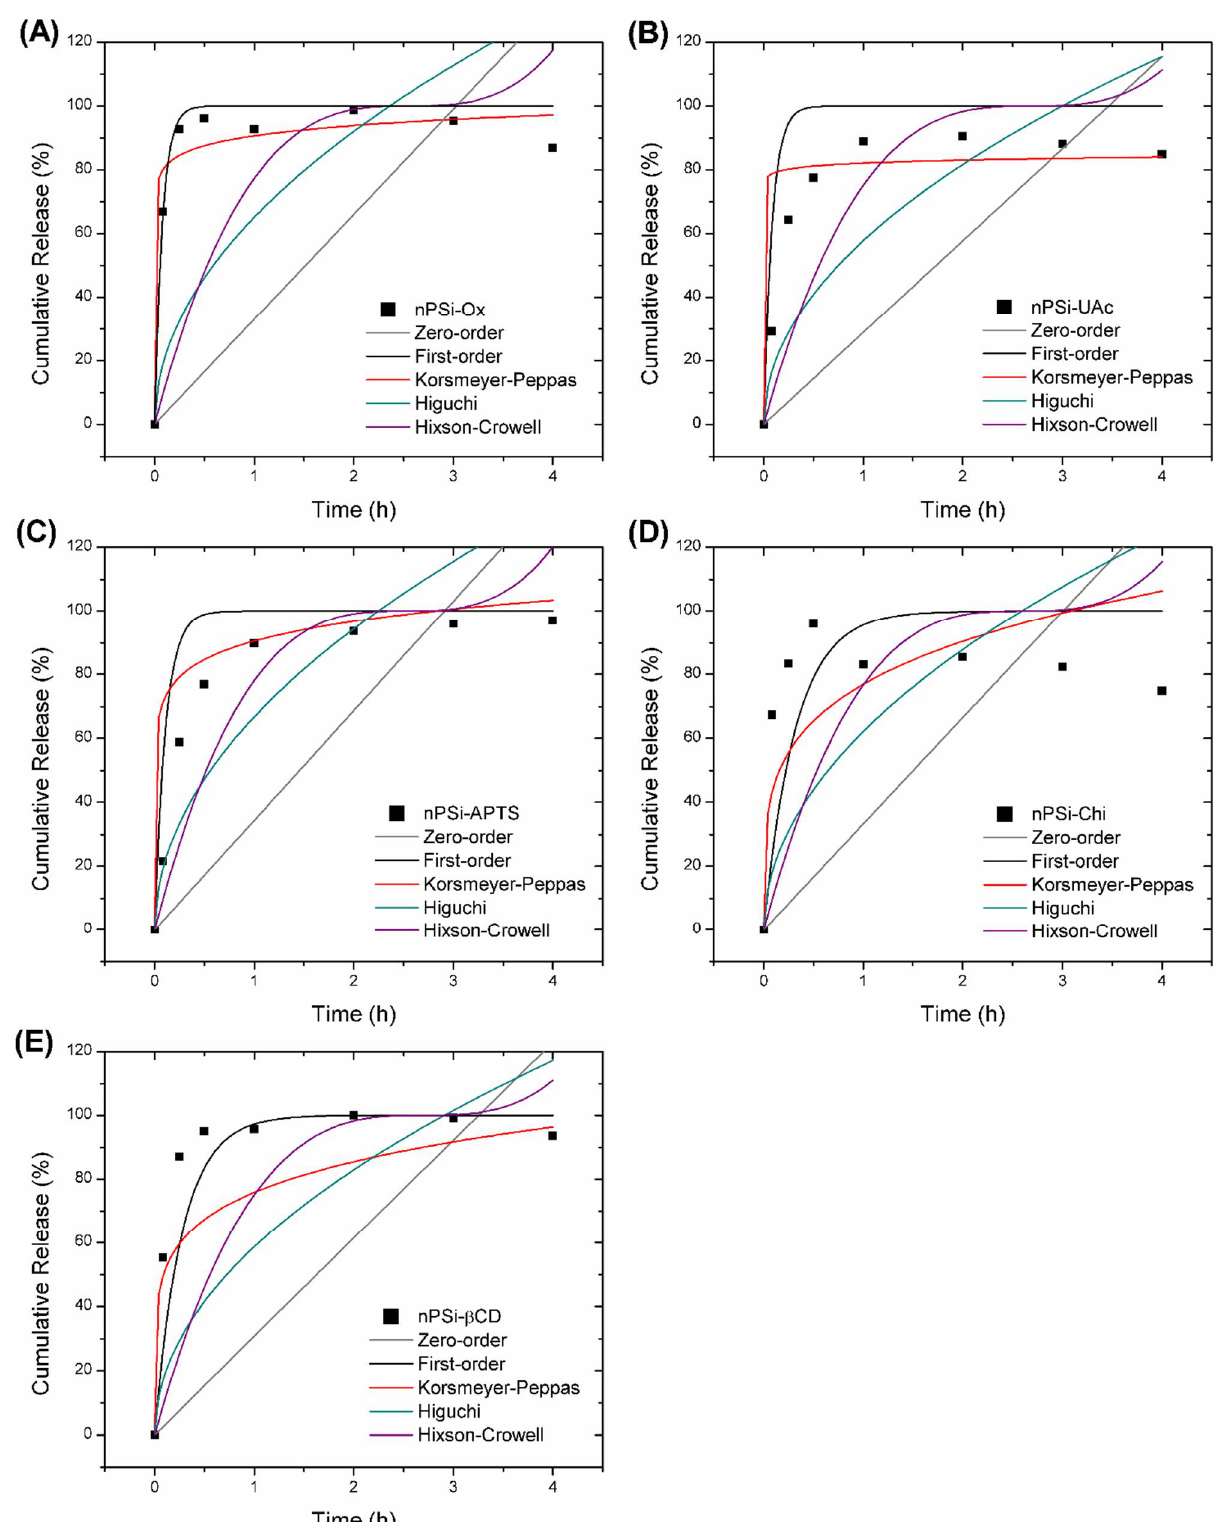
Figure 5. Essential oil kinetic release profile with different functionalities of nanostructured porous silicon. ( A ) nPSi-Ox, ( B ) nPSi-UAc, ( C ) nPSi-APTS, ( D ) nPSi-Chi, and ( E ) nPSi-βCD.